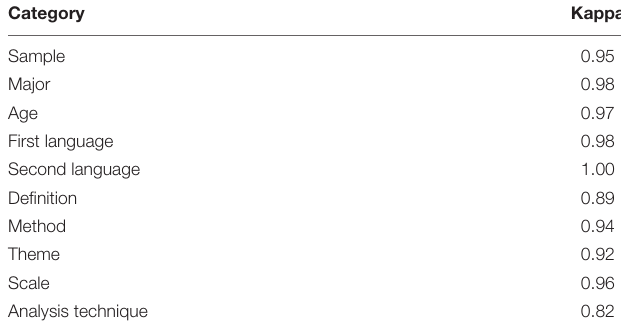
TABLE 1 | Reliability of